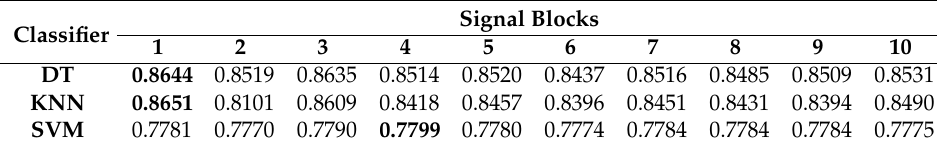
Table 6. Best accuracy rates for signal blocks using classifiers DT, KNN and SVM.